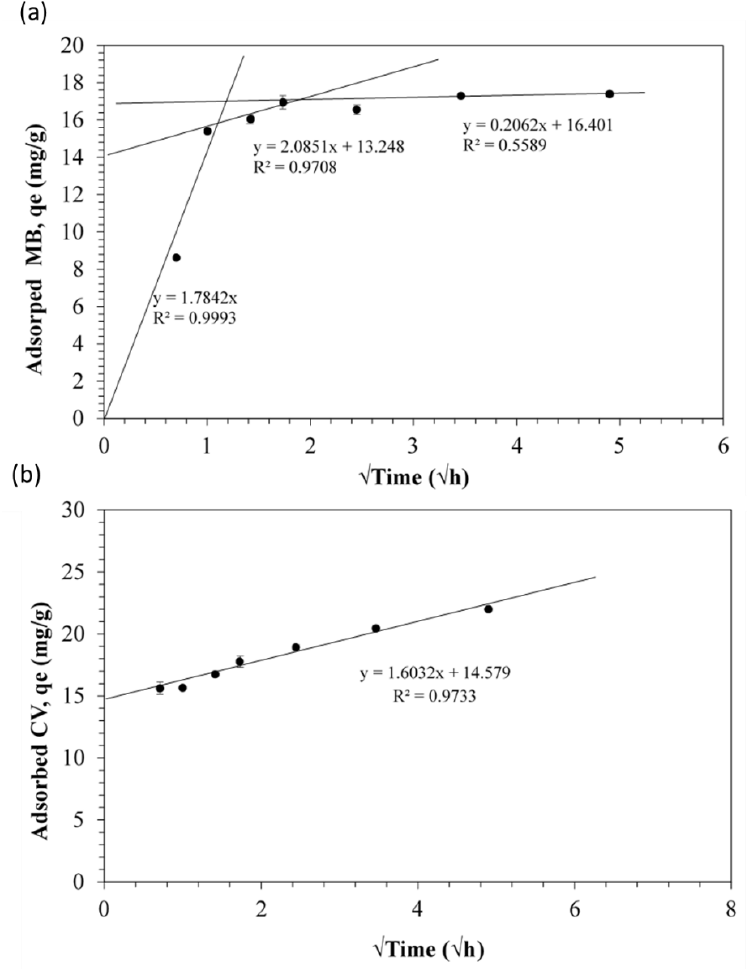
Figure 4. The kinetic profile represented by the intra-particle diffusion model for ( a ) methylene blue (MB) adsorption at 300-ppm concentration ( b ) crystal violet (CV) adsorption at 400-ppm concentration.